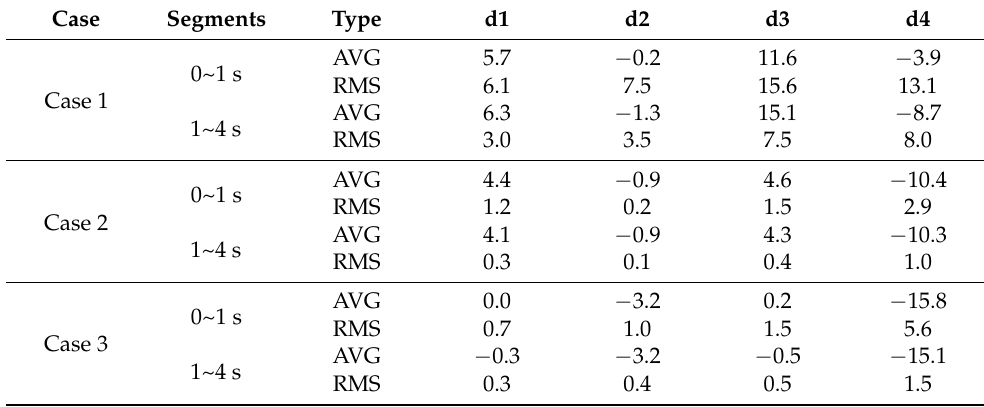
Table 3. Mean value of displacement measuring points and RMS amplitude